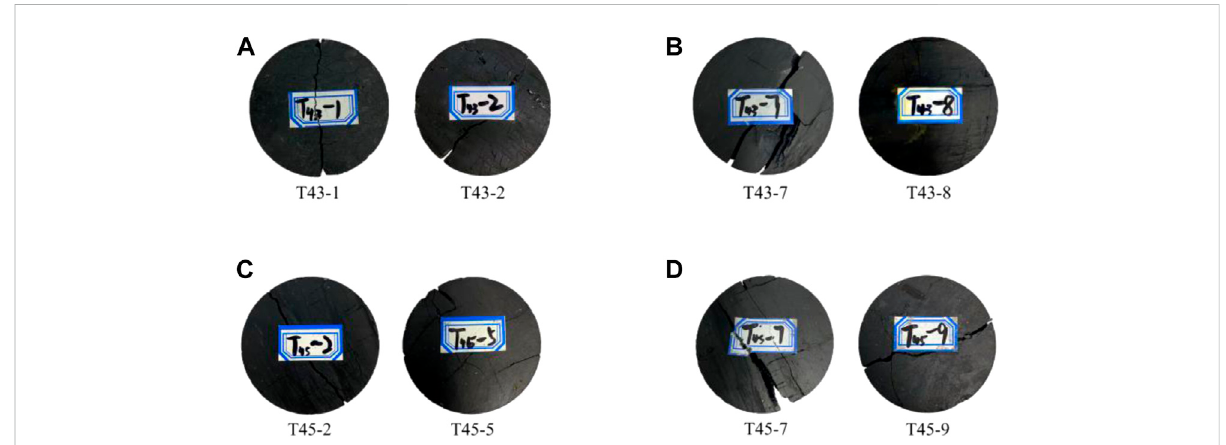
FIGURE 4 Typical coal samples splitting failure characteristics of 43# and 45# coal samples under natural and water-saturated conditions. (A) Natural stateof43#coalsamples. (B) Water-saturatedstateof43#coalsamples. (C) Naturalstateof45#coalsamples. (D) Water-saturatedstateof45#coal samples.